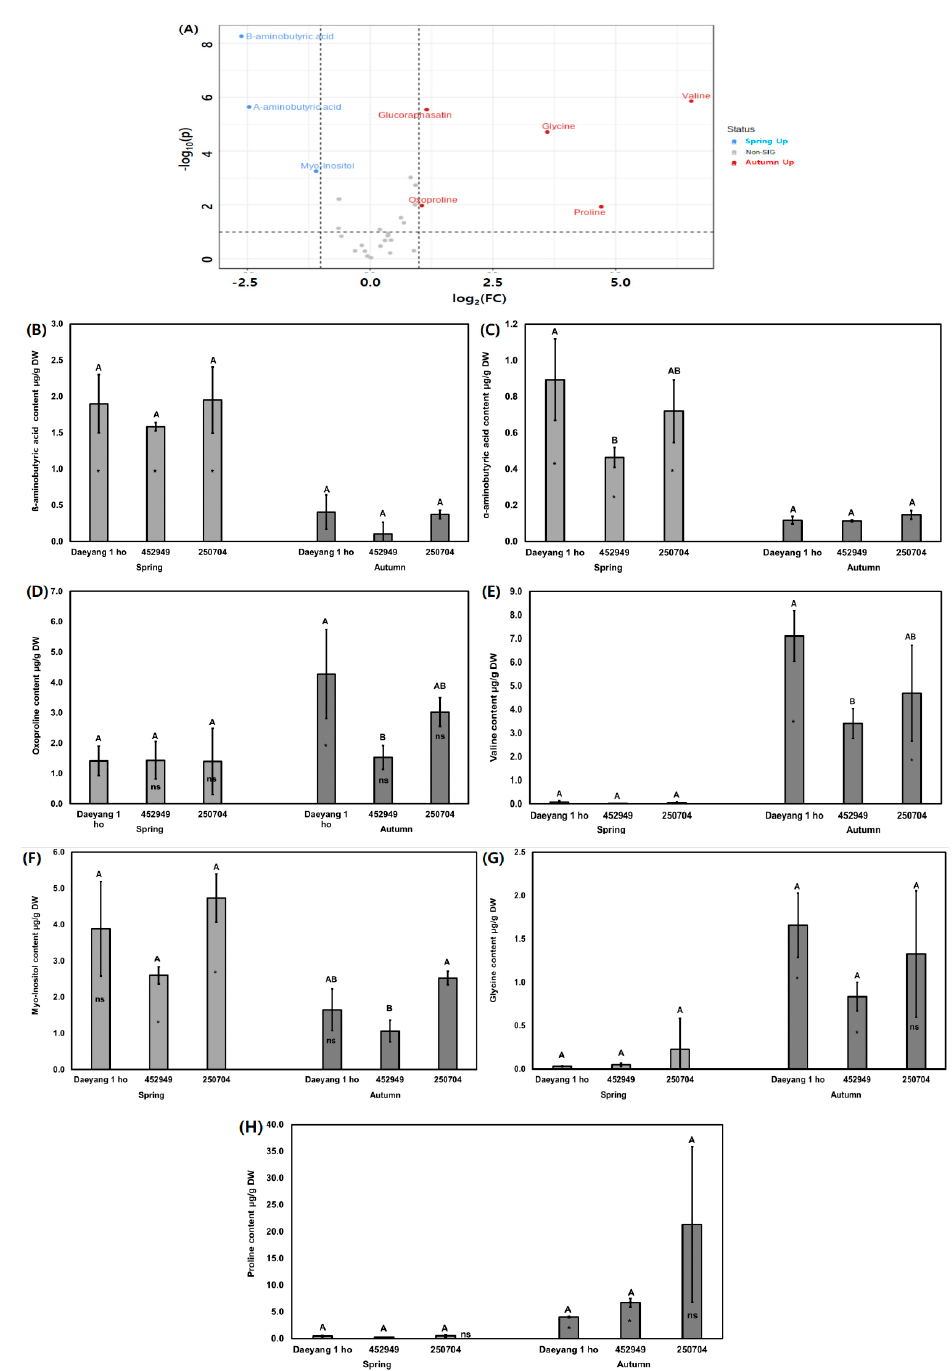
Figure 5. ( A ) Red dots (autumn up) and blue dots (spring up) in the volcano plot indicate significantly different water-soluble metabolites among the different cultivars and seasons ( p < 0.05); ( B – H ) The significantly different contents of water-soluble metabolites amongst the different cultivars and seasons are represented in a bar graph. Metabolite concentrations are expressed as ribitol equivalent concentration. The bars and error bars represent the mean ± standard deviation of three biological replications. Letters above the bars represent significant differences among different cultivars in the same season. Asterisks (*) and ns in the bars represent significant differences among different seasons in the same cultivar, as per Tukey’s HSD test ( p <